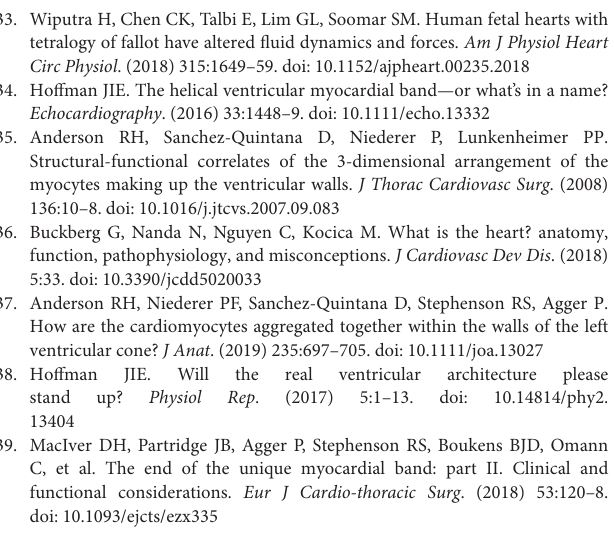
skeleton and ventricular outflow tracts in tetralogy of fallot. Ann Thorac Surg . (1990) 50:450–7. doi: